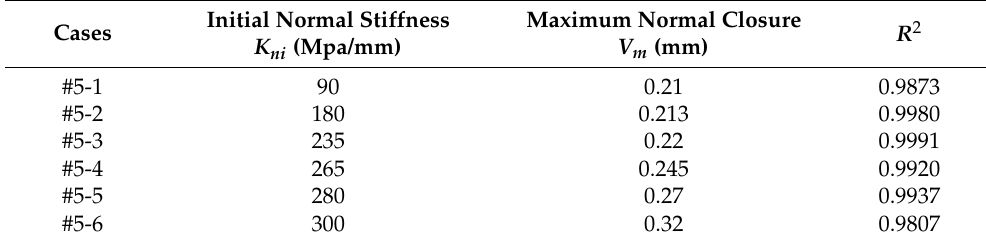
Table 5. Fitting parameters of normal compression